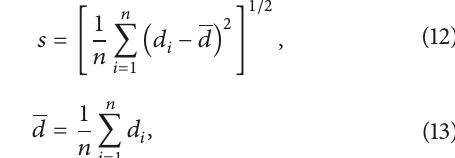
Figure 7: Diversity measure 𝑆